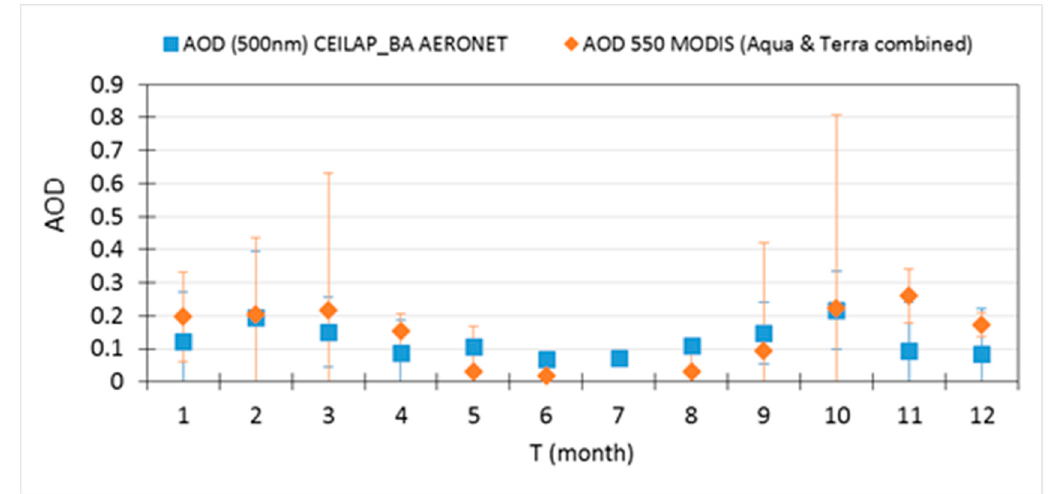
Figure 7. Monthly AOD (500 nm) mean at Ceilap-BA AERONET station (blue squares) and the corresponding 3 km × 3 km pixel of AOD (550 nm) from MODIS (orange diamonds) for 2014. Whiskers indicate the standard